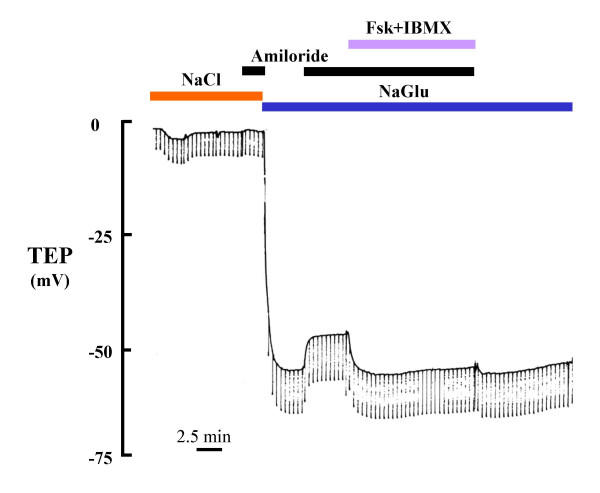
Effect of amiloride and Forskolin (Fsk, 5 μM) + IBMX (100 μM) on transepithelial potential (TEP) of bronchiole. In the presence of luminal Cl-, the effects of both amiloride and Fsk+IBMX on TEP were almost imperceptible (left side). However, when Cl- was substituted with Gluconate to more effectively reveal the Cl- conductance, addition of amiloride depolarized TEP and Fsk+IBMX hyperpolarized the TEP (right side), suggesting that the large Cl- conductance present in the epithelium mutes (shunts) the smaller changes in conductance occasioned by amiloride and Fsk when isotonic Cl- is present bilaterally. NaGlu: Na-gluconate